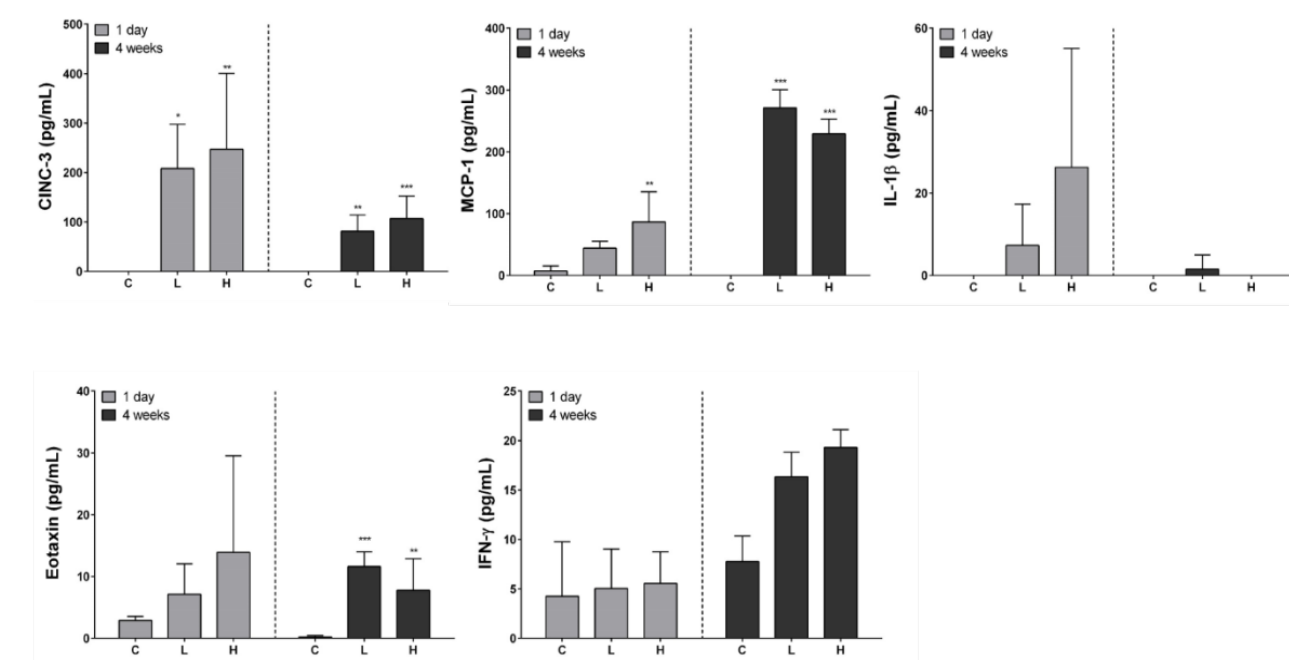
Figure 3. Proinflammatory cytokine analysis of bronchoalveolar lavage fluid (BALF) after intratra- cheal instillation of nickel oxide nanoparticles (NiO NPs). Levels of cytokine-induced neutrophil chemoattractant-3 (CINC-3), eotaxin, monocyte chemoattractant protein (MCP)-1, interferon (IFN)- γ , and interleukin (IL)-1 β are indicated. Data are presented as mean ± standard deviation (SD) of each group. One-way analysis of variance (ANOVA) was performed for the comparison between the NiO NPs-treated and control groups with statistical significance indicated by * p < 0.05, ** p < 0.01, and *** p < 0.001. C: control group; L: low-dose group (50 cm 2 /rat); H: high-dose group (150 cm 2 /rat).